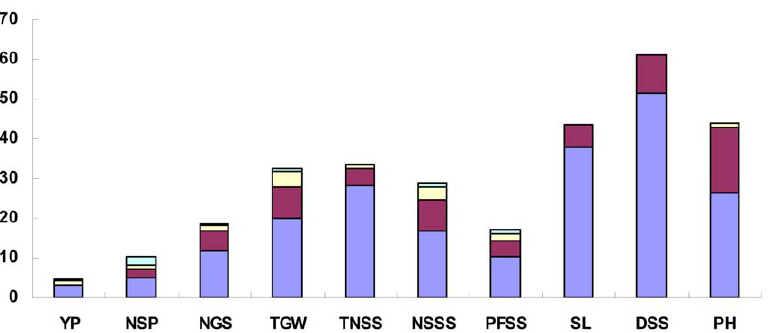
Figure 2. Phenotypic variation explained (PVE) by different genetic components for yield-associated traits in wheat DH lines.